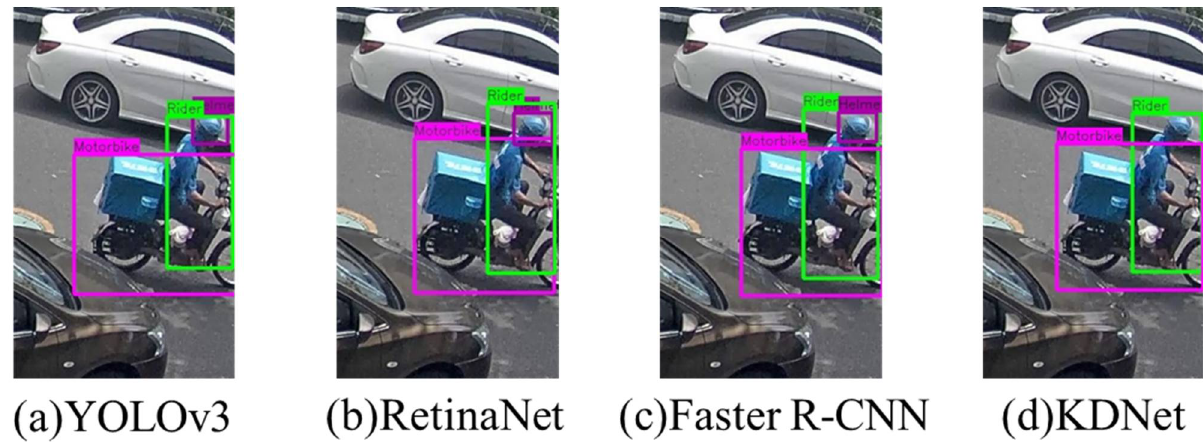
Figure 7. Typical detection results in which the proposed KDNet failed. 432